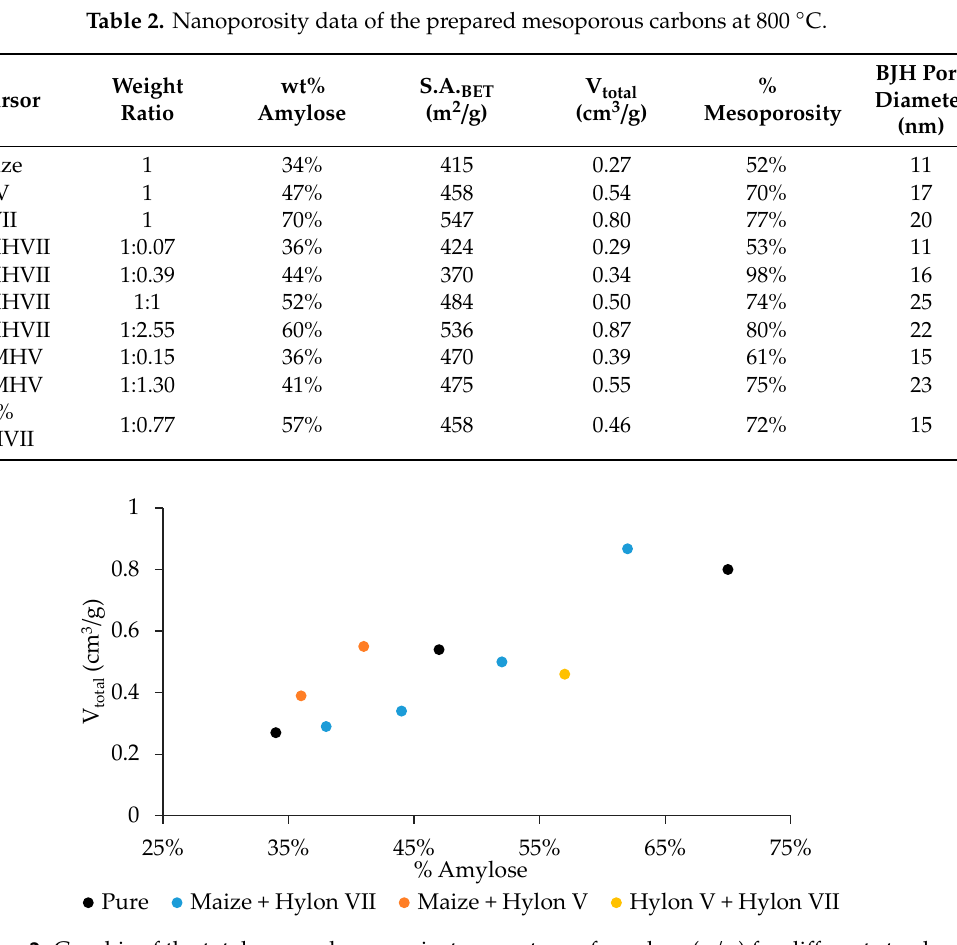
VII, and Hylon V + Hylon VII with similar amylose content but di ff erent mesoporosity. The shape of the curve changes when the amylose content varies due to the di ff erent content of amylose vs. amylopectin, that have di ff erent molecular weight. However, the shape of the curve is similar for di ff erent starches with similar amylose content, and the maximum of the curve is the same. This indicates that the mixtures with a similar amylose content have the same molecular weight after treatment with IL, which means that the molecular weight is not responsible for di ff erent